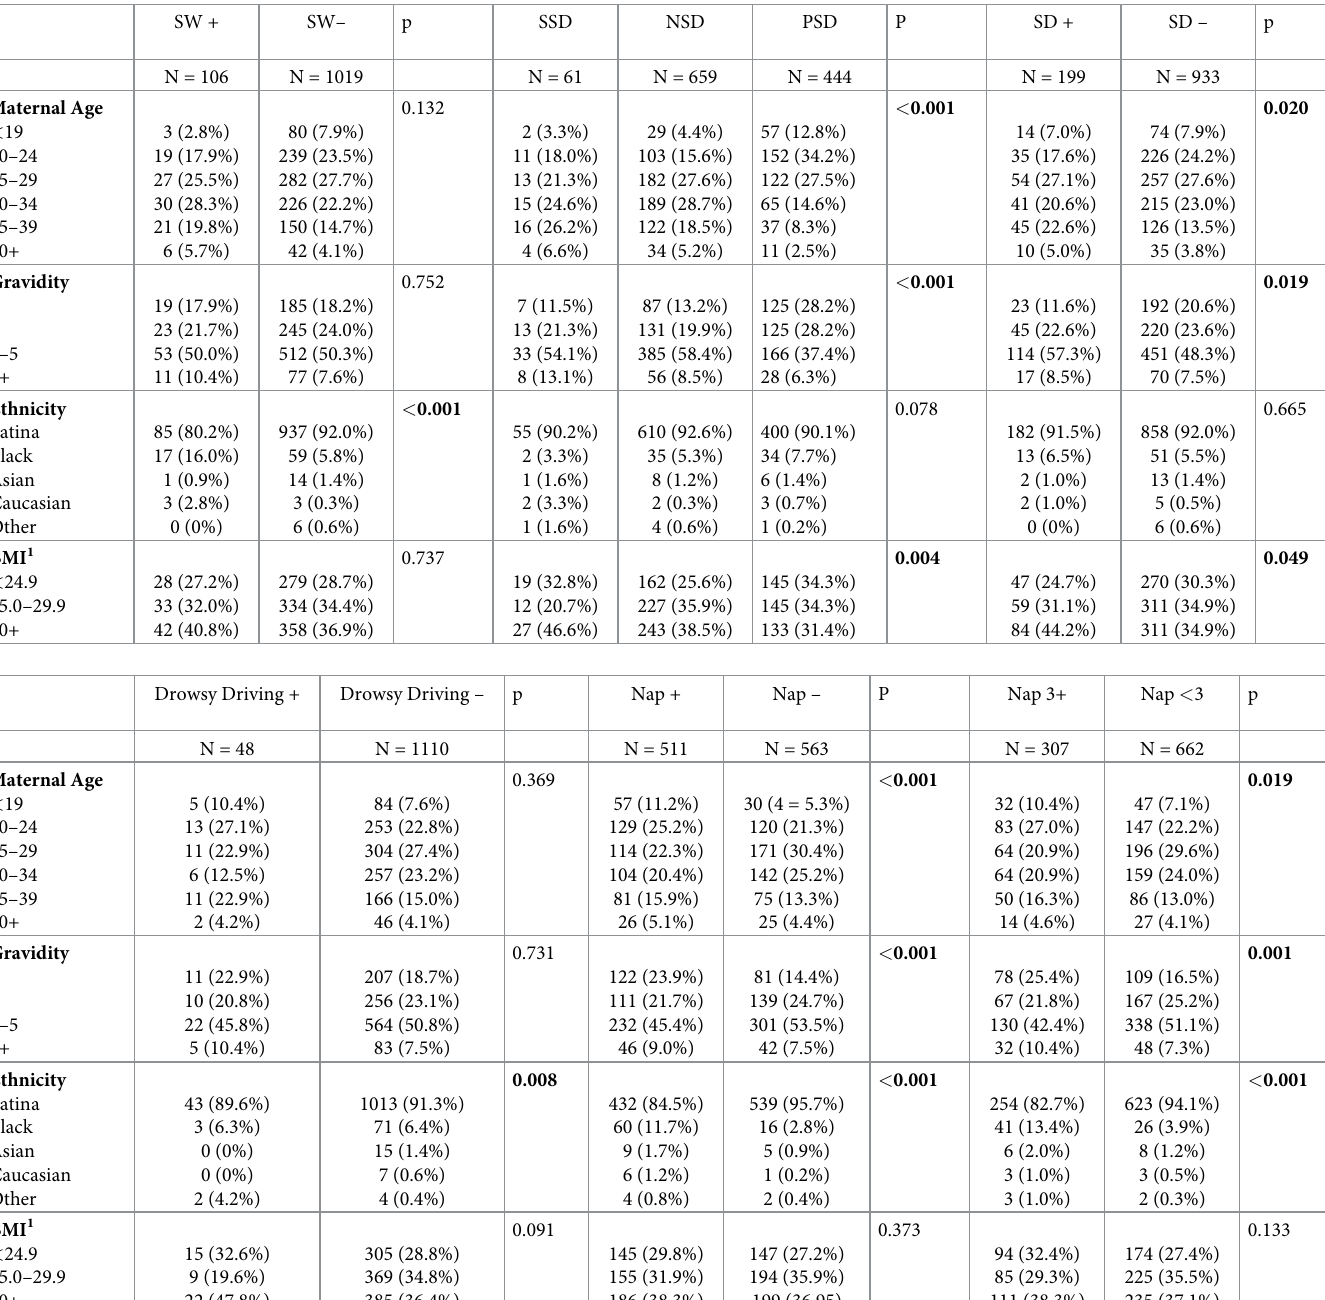
Table 1. a: Maternal characteristics of the study population by shift work (SW), sleep duration (short sleep duration (SSD), normal sleep duration (NSD), pro- longed sleep duration (PSD)), sleep deprivation (SD), drowsy driving, and napping. b: Maternal characteristics of the study population by drowsy driving, and